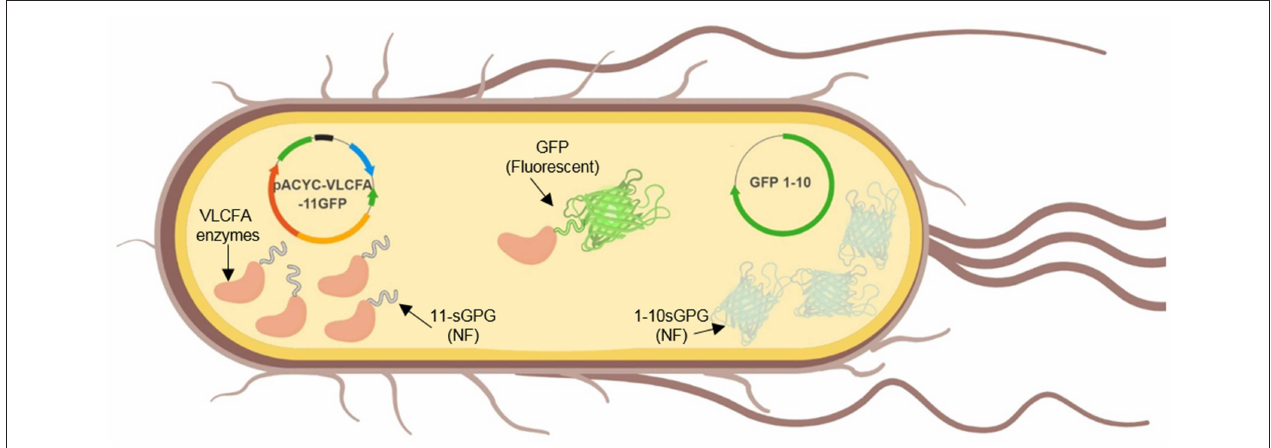
FIGURE 3 | Graphical illustration of the in vivo expression of self-assembly GFP and the VLCFA biosynthesis enzymes.